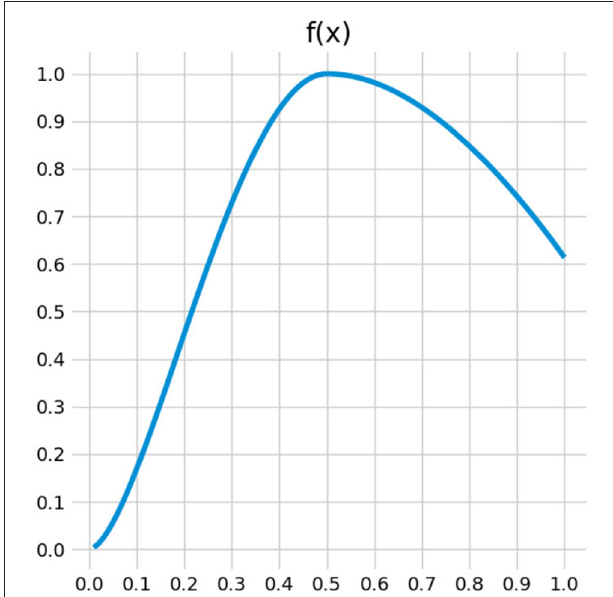
FIGURE 4 | Function used for uncertainty estimation ( f ). This function gives a higher probability of choice to uncertain classification, but also to certain classification to the chosen class, i.e., the one with fewest